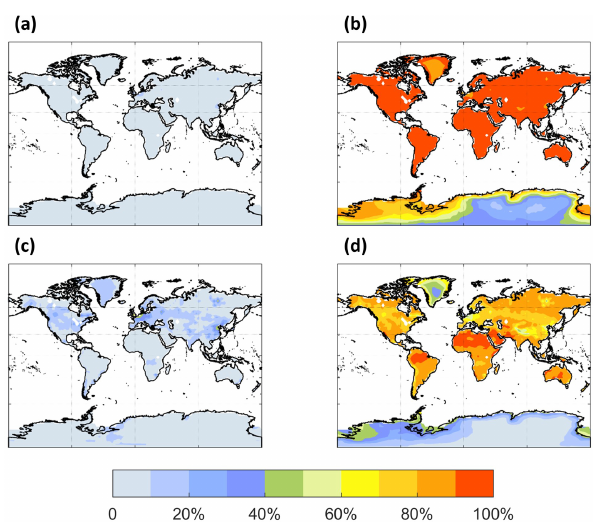
Figure 2. The annual PBL-averaged MT-bRO 2 consumption frac- tions by NO (a, c) and autoxidation (b, d) from the Low- Prod_Photo (a, b) and LowProd_Photo_ kauto_Slow (c, d) exper- iments. The autoxidation rate constant is ∼ 1.0 and ∼ 0.1s − 1 at 298K for the respective experiments. The fractions by HO 2 , NO 3 , and RO 2 are shown in Fig. S1.